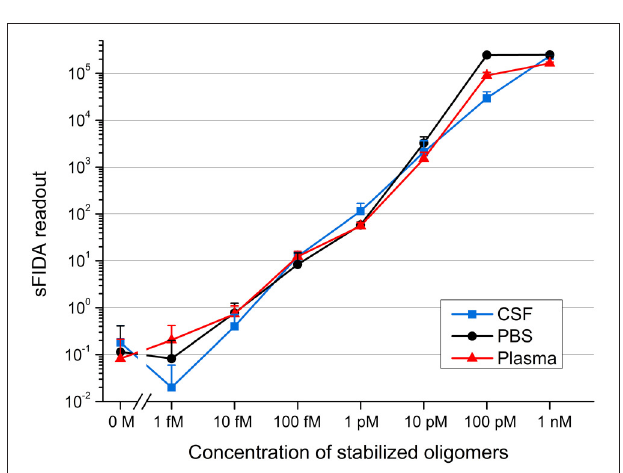
FIGURE 3 | sFIDA readout of stabilized oligomers diluted in CSF, PBS, and a plasma fraction. Shown are mean values and standard deviations from fourfold (samples containing stabilized oligomers) or 21-fold (all blanks) determinations. Cutoffs for channel 635nm/channel 488nm: CSF, 3268/2339; PBS, 4082/2773; plasma fraction,